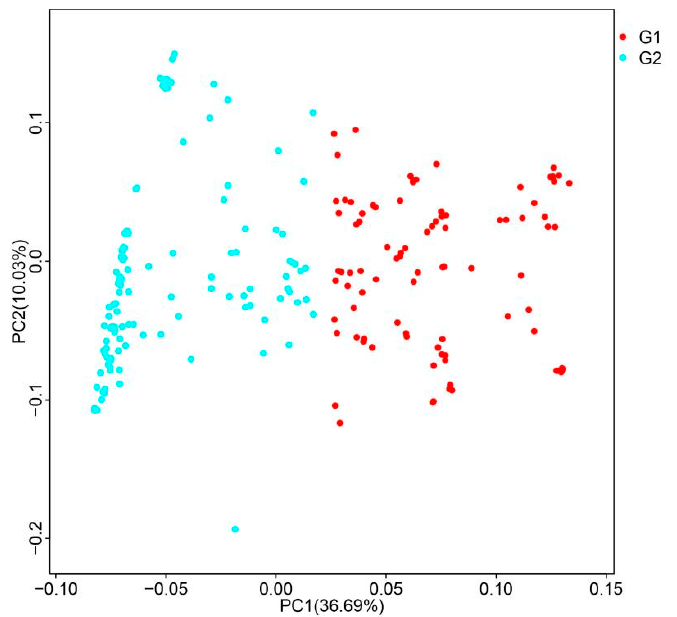
Figure 3. The PCA scatter plot. PCA analysis of 220 DXWR lines according to the first two eigenvectors constructed by PLINK software. G1: G1 subpopulations of DXWR, G2: G2 subpopulations of DXWR.